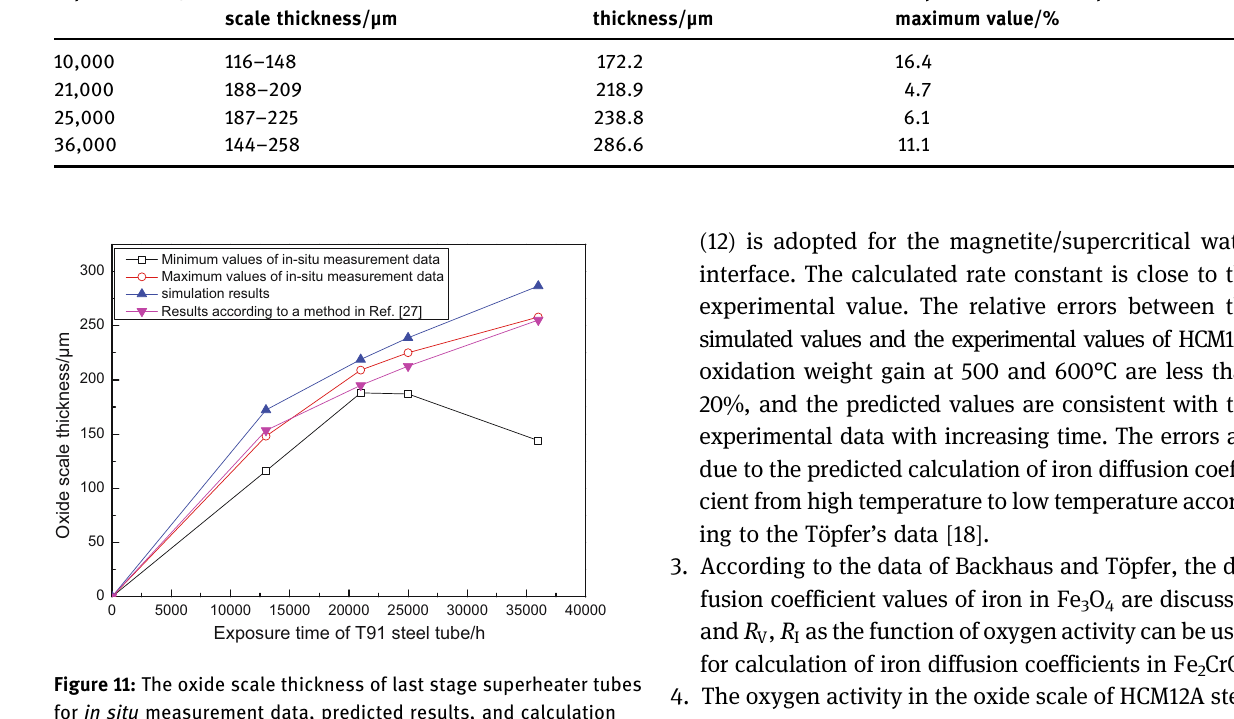
Table 7: In situ measurement data and predicted results of oxide scale thickness Exposure time/h In situ measurement data of oxide